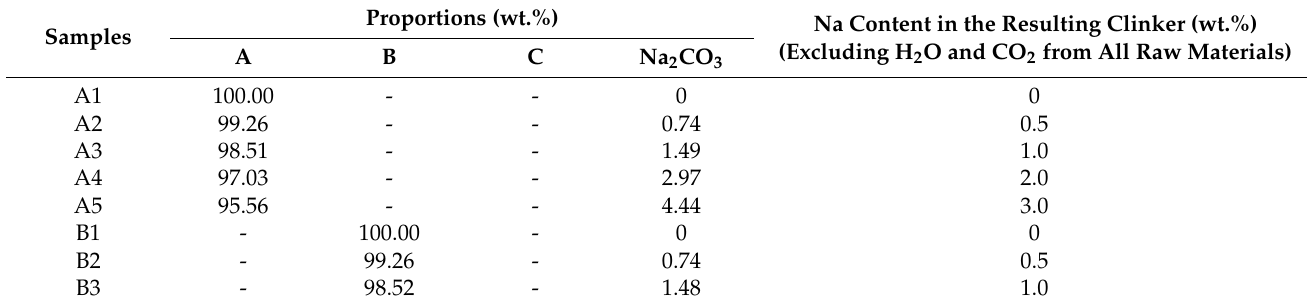
Table 2. Composition of samples A1–A5, B1–B5 and